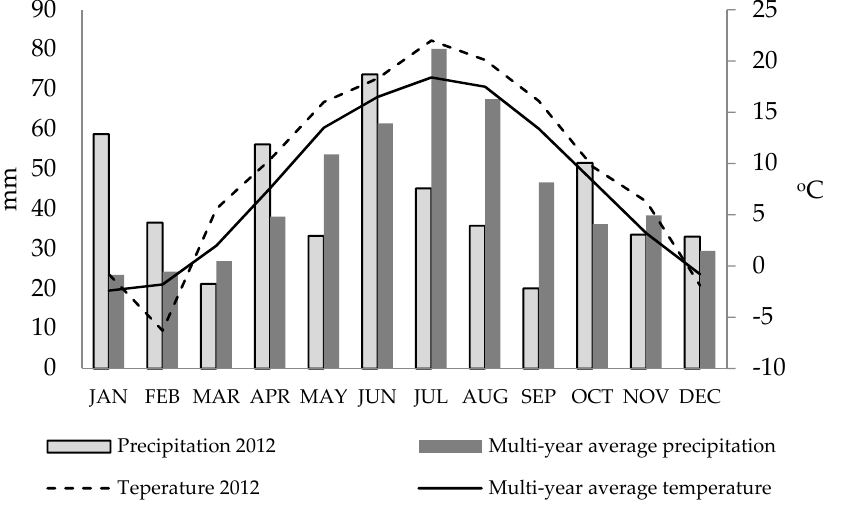
Figure 1. Climatic conditions in the Mazovia Province in 2012 and multi ‐ year average climatic conditions (1921 ‐ 2012).